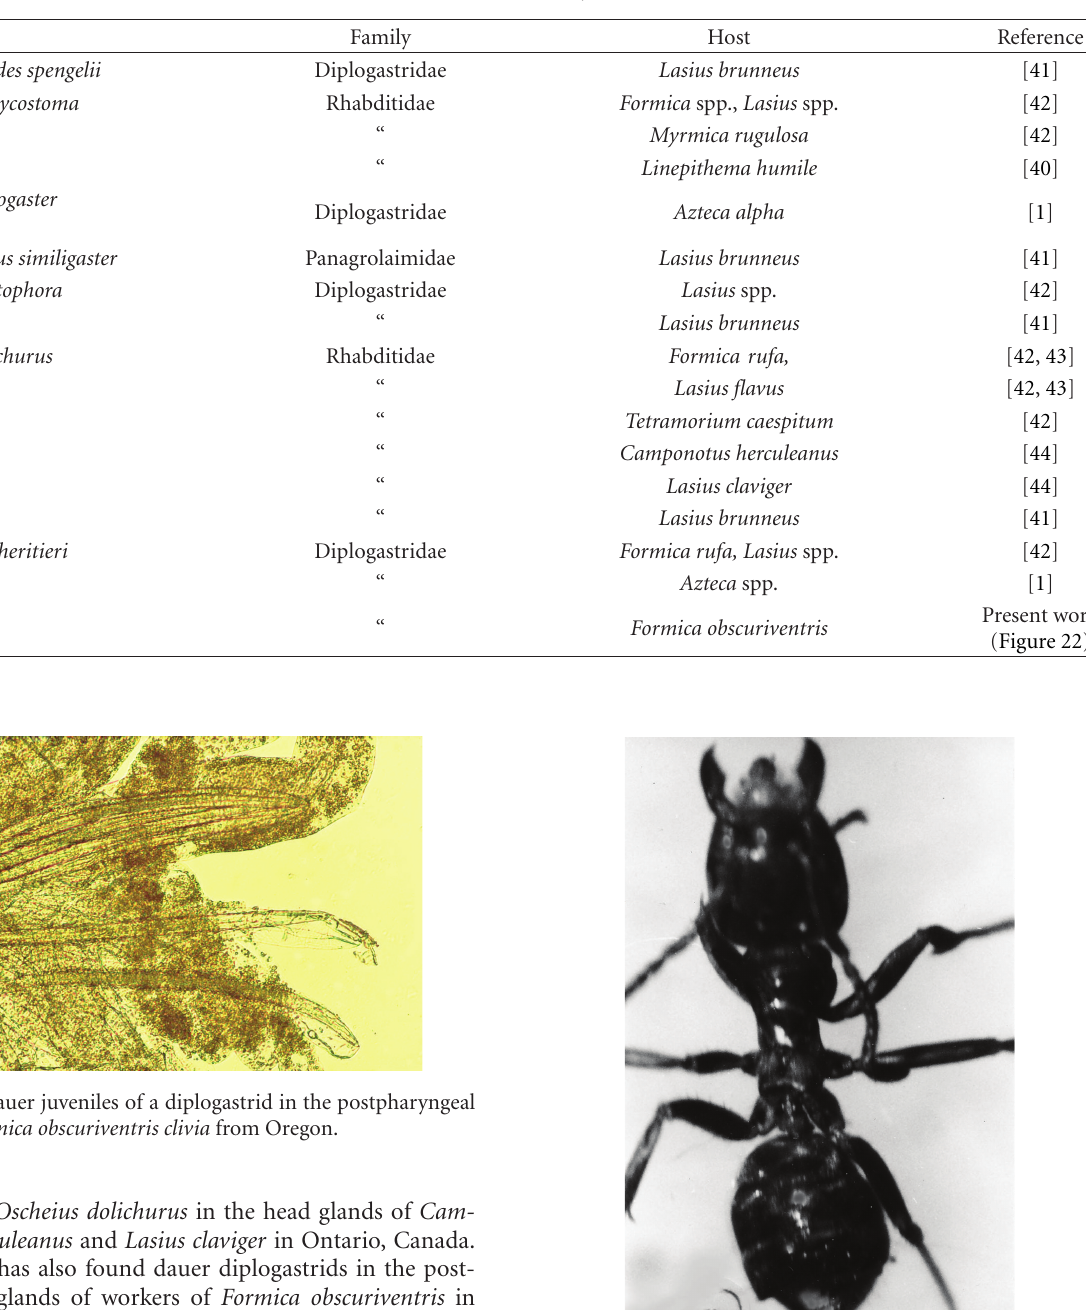
Table 3: Juvenile nematodes of Rhabditida and Tylenchina associated with ants.